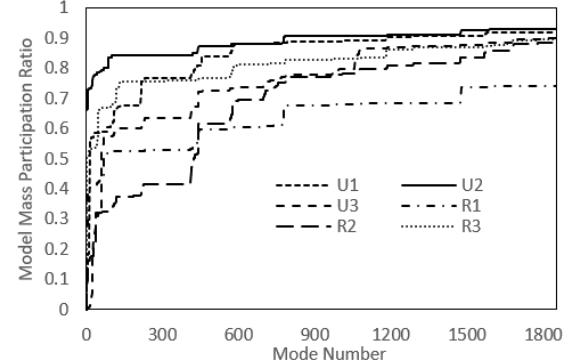
Figure 9. Mass participation vs. mode number.